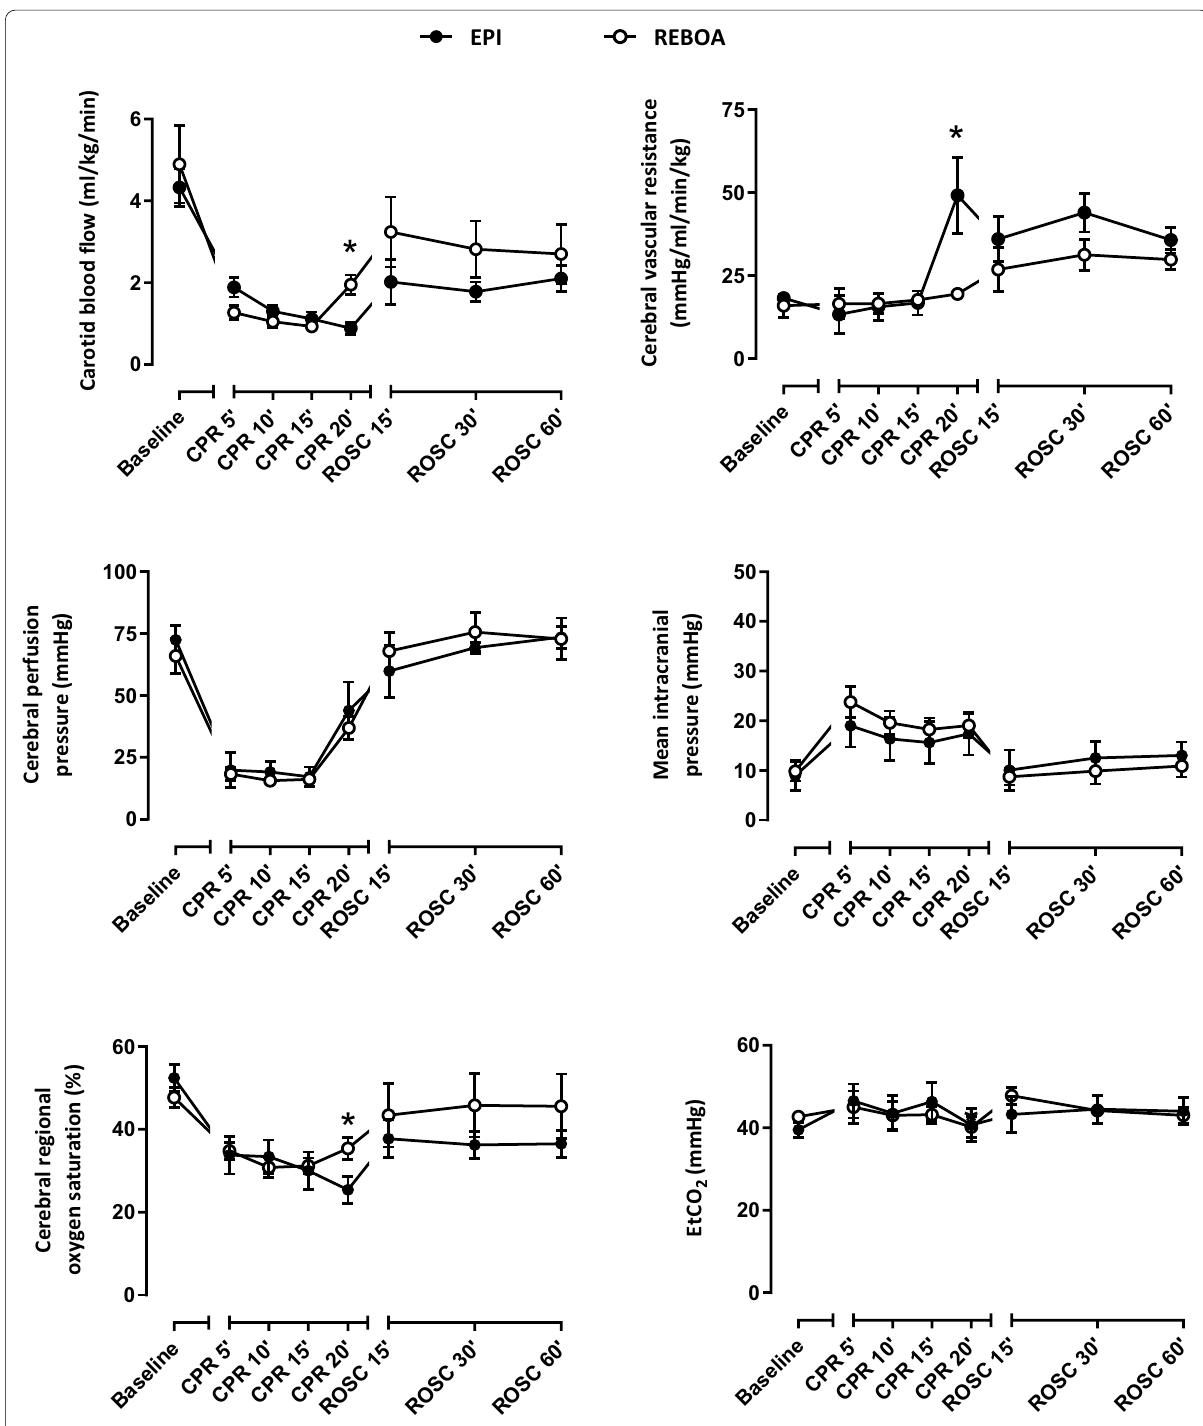
Fig. 2 Carotid blood flow, cerebral vascular resistance, cerebral perfusion pressure, mean intracranial pressure, cerebral regional oxygen saturation and end-tidal CO2 throughout experimental protocol. * P < 0.05 between EPI and REBOA group; CPR, cardiopulmonary resuscitation; ROSC, return of spontaneous circulation. N 6 in both groups, except for cerebral oximetry, which was only available in 5 animals in the Epi vs 6 in the REBOA = group, respectively. Statistical comparisons were only made at each time-point between groups, but not between